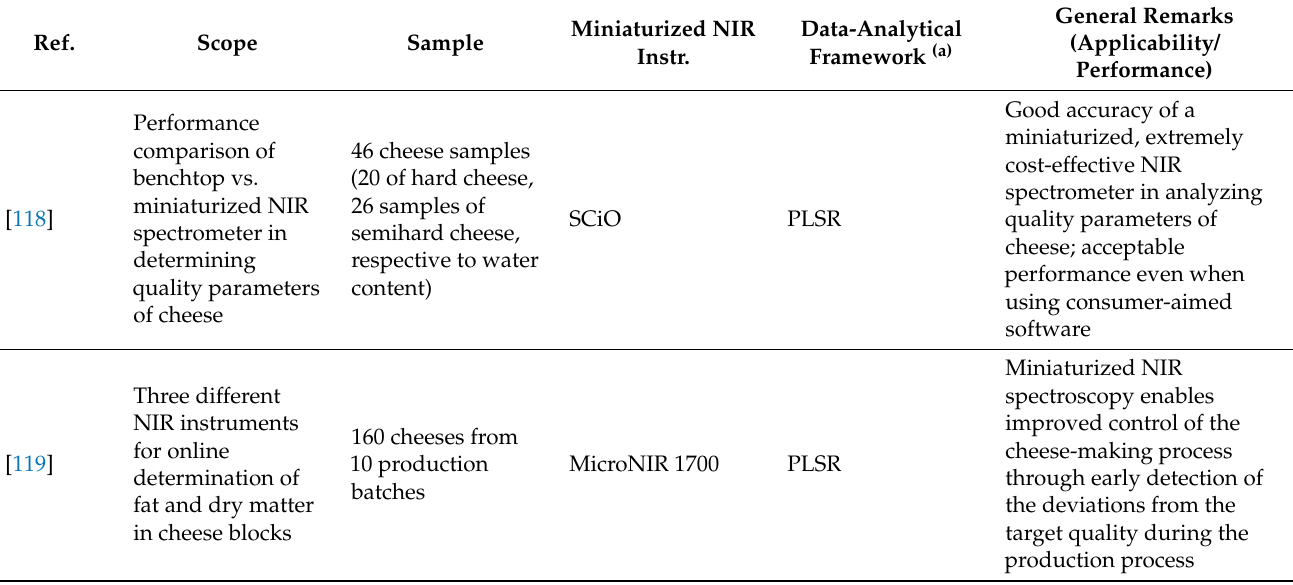
Table 4. Recent research activity oriented toward miniaturized NIR spectroscopy in the area of dairy-product